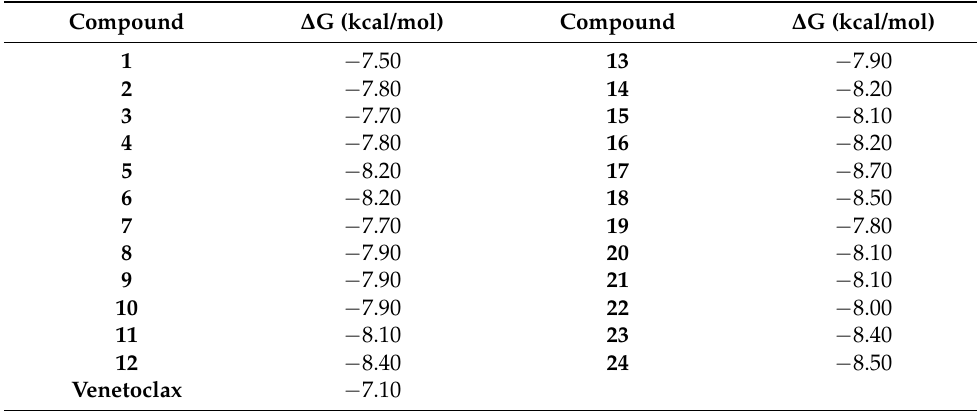
Table 10. Vina affinity scoring values ( ∆ G) [kcal/mol] for compounds 1 – 24 and venetoclax. Compound ∆ G (kcal/mol) Compound ∆ G (kcal/mol) 1 −